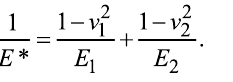
pendent of u 0 . This may change, if the force–displacement loop takes some other shape. Figure 2D shows the force–displace- ment loop according to Cattaneo and Mindlin. For contacts following the CM model, Δ f and ΔΓ decrease and increase with amplitude,